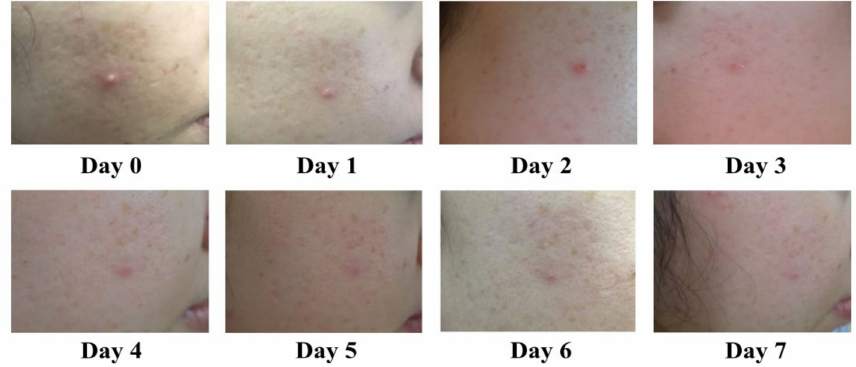
Figure 5. Representative photographs demonstrate improvement of acne in a volunteer treated with the commercial prototype, twice daily for 7 days.